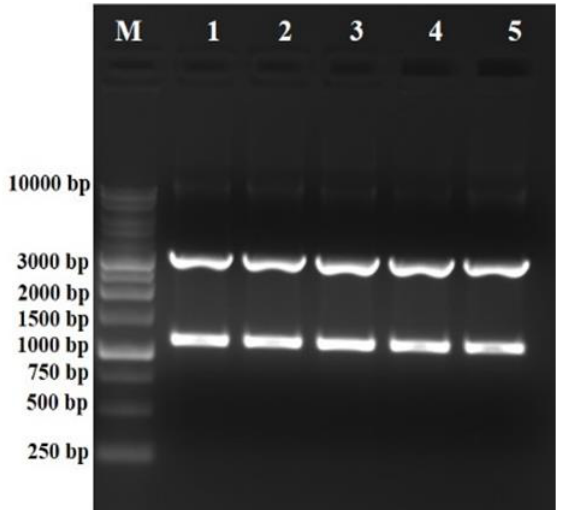
Figure 4. Screening and confirmation of positive putative clones by restriction digestion, respec- tively. Lanes 1 – 5: restriction digestion with Spe I+ Hind III released a fragment of ~1.078 kb of the phlD gene and ~3 kb fragment of pBluescript (SK+) vector backbone.